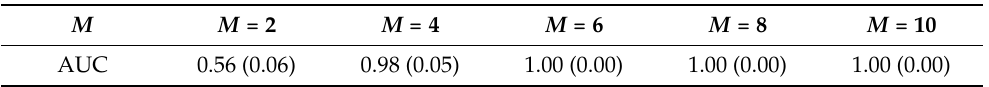
Table 5. Mean AUC (and standard deviation) of KNMDA for sparsity patterns as the number of training samples M